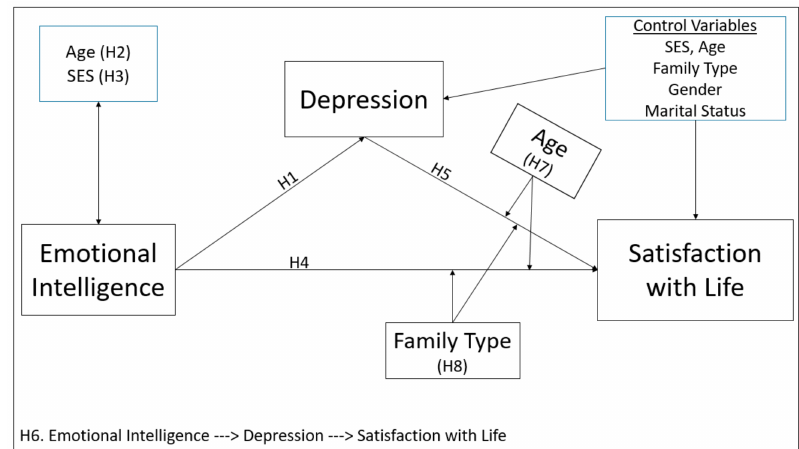
Figure 1. Schematization of the hypothesized